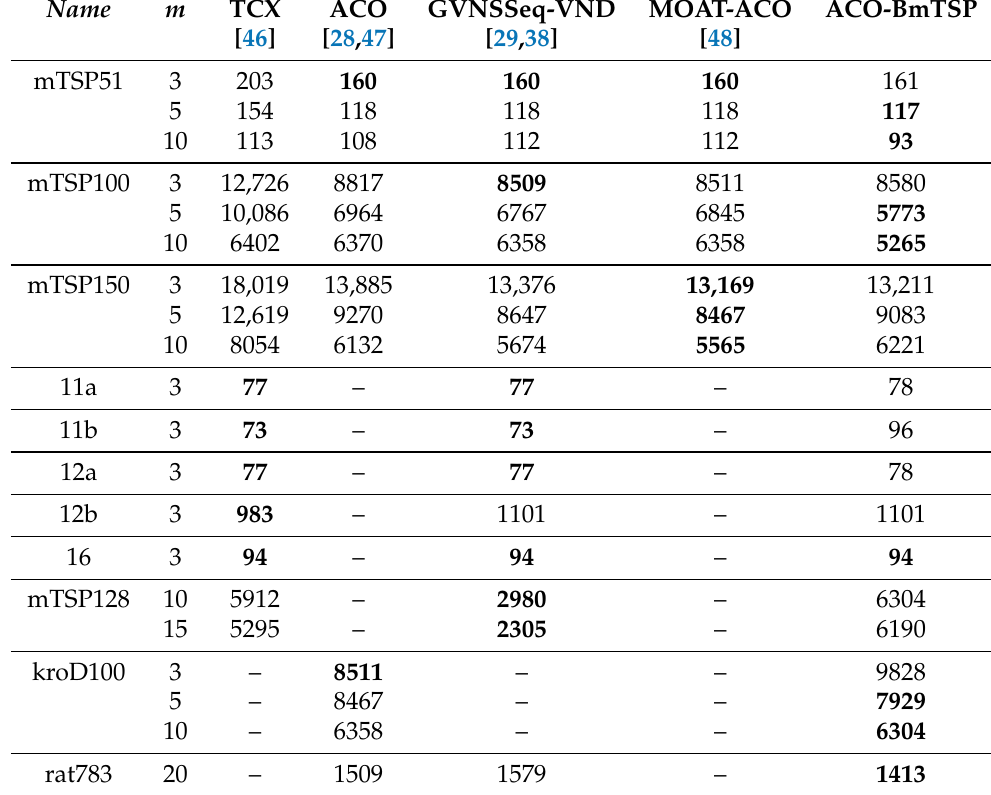
Table 3. Comparison with other